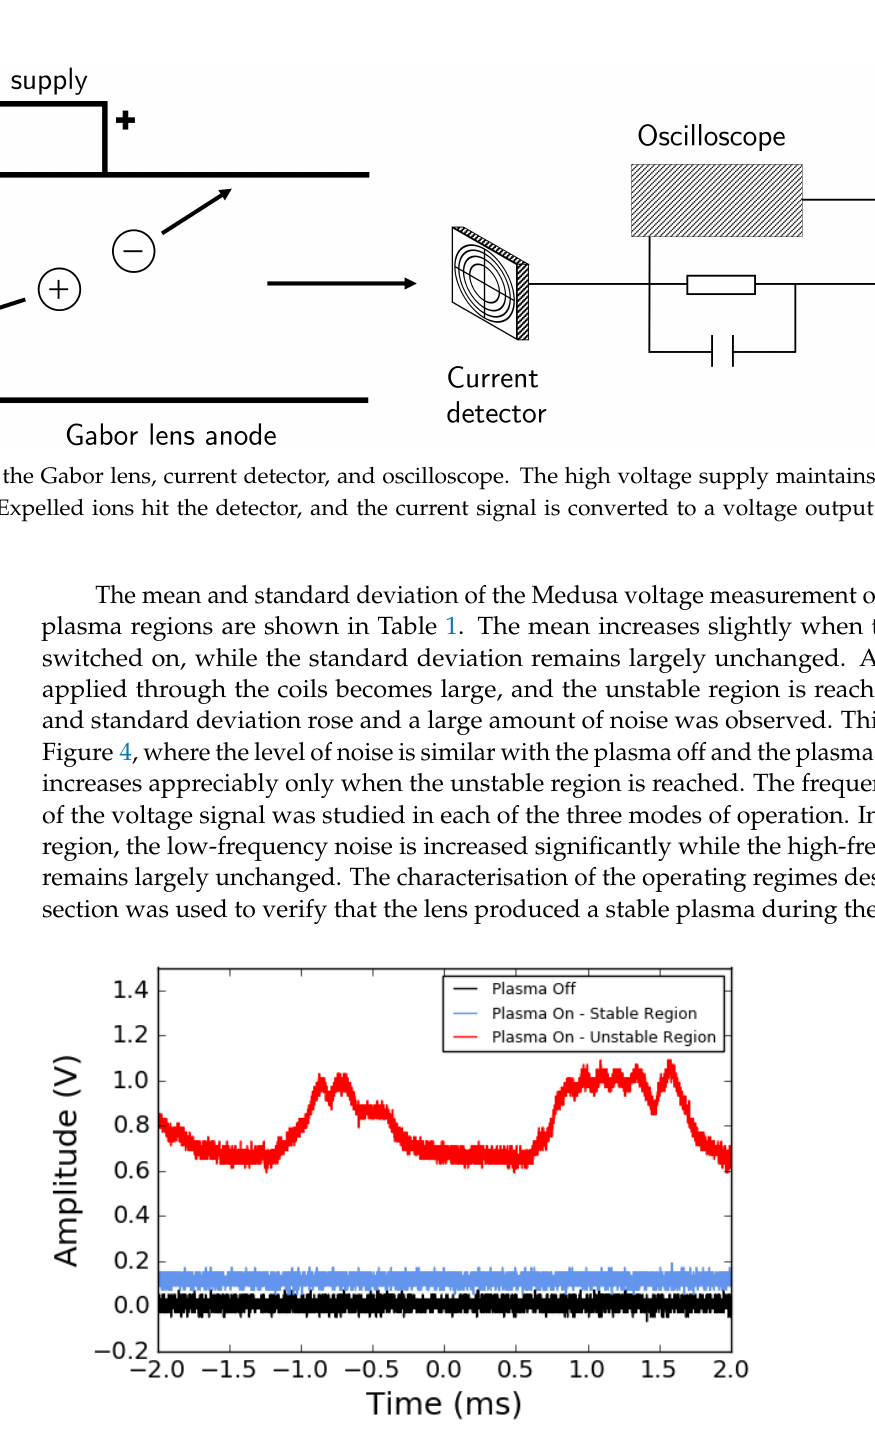
Figure 4. Amplitude of signal from the Medusa detector in three regions: plasma off, plasma on, and plasma on in unstable region. The time range is given 0.0004s, and the time resolution of the measurement is 4 × 10 − 7 s. The voltage range is 0.5V with a resolution of 0.01V. Table 1. Mean and Standard Deviation values for Plasma Off, On, and Unstable regions shown in Figure 4. Mean